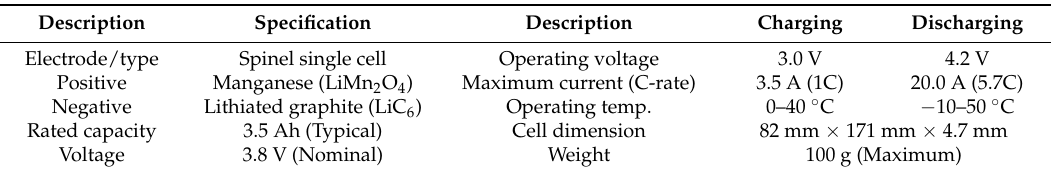
Table 1. Cell specification.